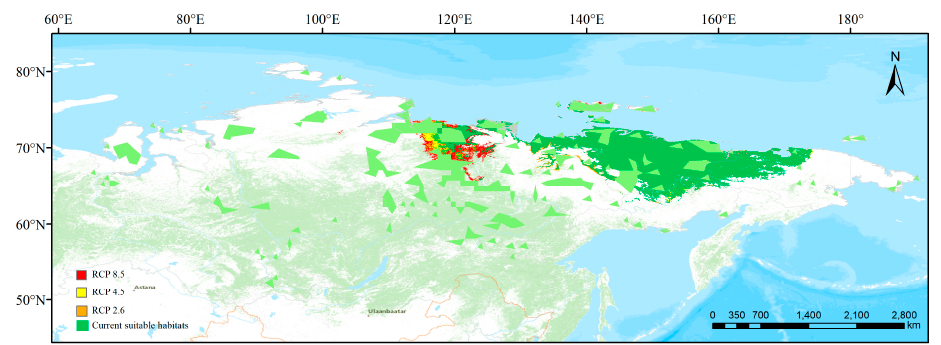
Figure 5. Protection gaps. The existing protected areas are overlaid with the current suitable distri- bution areas for the conservation vacancy analysis, and the remaining dark green part represents areas that are not under conservation management. Figure 6. Conservation gaps under different climate scenarios in 2050: red indicates the protection gaps in the case of RCP2.6; yellow represents the protection gaps in the case of RCP4.5; and orange represents the protection gaps in the case of RCP8.5.